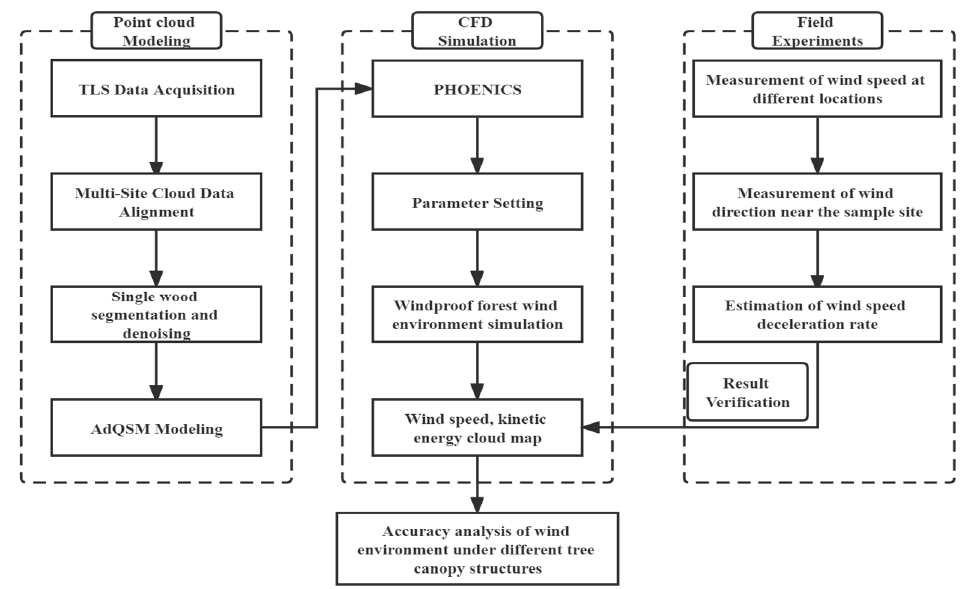
Figure 1. Schematic representation to illustrate the main steps of our method.